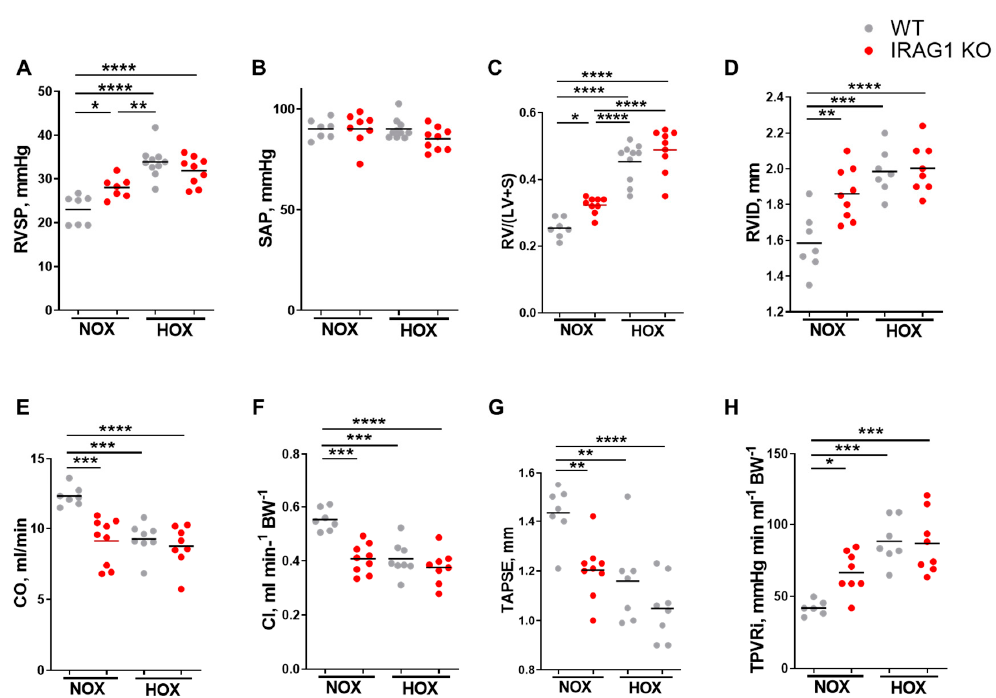
Figure 2. Disruption of IRAG1 gene in mice showed signs of right ventricular dysfunction in normoxic conditions. ( A – H ) WT and IRAG1 KO mice were kept under normoxic or hypoxic (10% O 2 ) for five weeks and then evaluated for echocardiographic variables and went through right heart catheterization. Variables measured were right ventricular systolic pressure (RVSP, A ), systemic arterial pressure (SAP, B ), ratio of right ventricular weight to left ventricular wall plus septum weight [{RV / (LV + S)}, C ], right ventricular internal diastolic diameter (RVID, D ), cardiac output (CO, E ), cardiac index (CI, F ), Tricuspid annular plane systolic excursion (TAPSE, G ), total pulmonary vascular resistance index (TPVRI, H ). Number of animals used: ( A ) Normoxia—seven WT and seven IRAG1 KO, hypoxia—10 WT and 9 IRAG1 KO; ( B ) normoxia—seven WT and eight IRAG1 KO, hypoxia—10 WT and 9 IRAG1 KO; ( C ) normoxia—seven WT and nine IRAG1 KO, hypoxia—10 WT and 9 IRAG1 KO; ( D ) normoxia—seven WT and nine IRAG1 KO, hypoxia—seven WT and eight IRAG1 KO; ( E ) normoxia—seven WT and nine IRAG1 KO, hypoxia—eight WT and eight IRAG1 KO; ( F ) normoxia—seven WT and nine IRAG1 KO, hypoxia—eight WT and eight IRAG1 KO; ( G ) normoxia—seven WT and nine IRAG1 KO, hypoxia—seven WT and eight IRAG1 KO; ( H ) normoxia—six WT and eight IRAG1 KO, hypoxia—seven WT and eight IRAG1 KO. All quantified data were represented as individual point and bar indicates the mean, * p < 0.05, ** p < 0.01, *** p < 0.001, **** p < 0.0001, comparison of multiple groups were performed by one-way ANOVA, followed by Tukey’s multiple comparisons test between the groups.